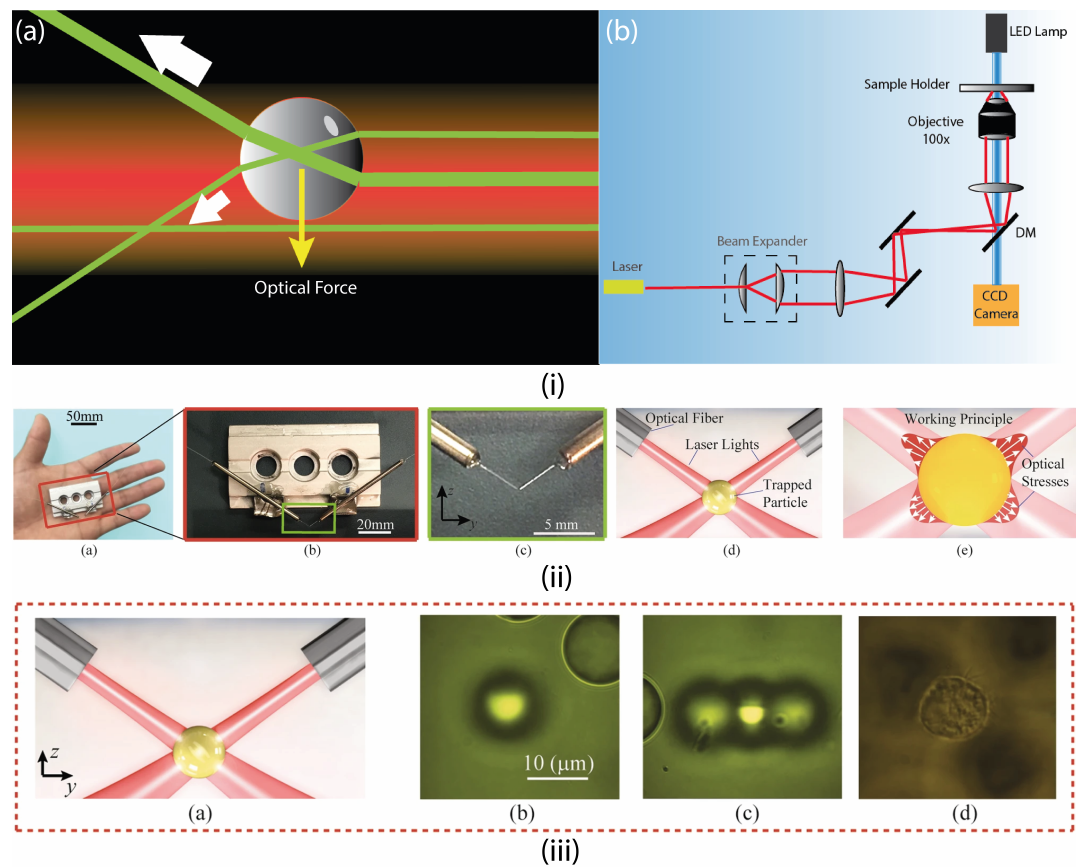
Figure 5. ( i ) Manipulation with Optical tweezers ( a ) working principle: momentum of light pushing a microparticle towards the center of the laser beam and ( b ) basic setup of a conventional optical tweezers system, ( ii ) all-fiber modular optical tweezers with same basic working principle but in a compact dimension, and ( iii ) 3D trapping capabilities of AFMOT ( a ) fiber schematic, ( b ) single, ( c ) multiple trapped microparticle (polystyrene beads, size: 15 µ m), and ( d ) trapped fibroblast cell [133]. Reproduced under the terms of the CC-BY